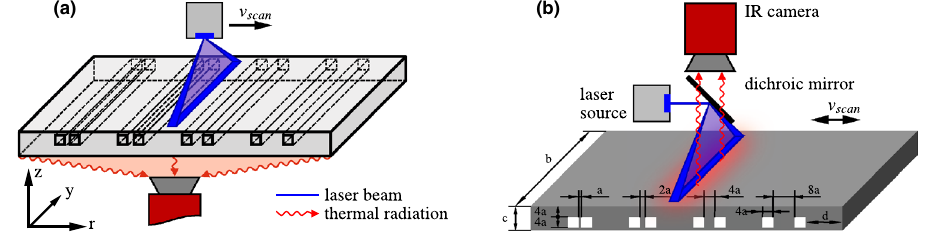
Figure 1. The IR camera and the specimen were placed for both configurations on a linear table so that both components are moved with a certain velocity v scan . ( a ) Transmission configuration: the additively manufactured stainless steel specimen (sandblasted from both sides to increase the emissivity) is shown with details inside. ( b ) Schematic of the setup in reflection configuration. The specimen with eight cavities and different distances is shown ( a = 0.5 mm, b = 40 mm, c = 4.5 mm, d = 7 mm). The arrows in ( a , b ) represent the direction of the